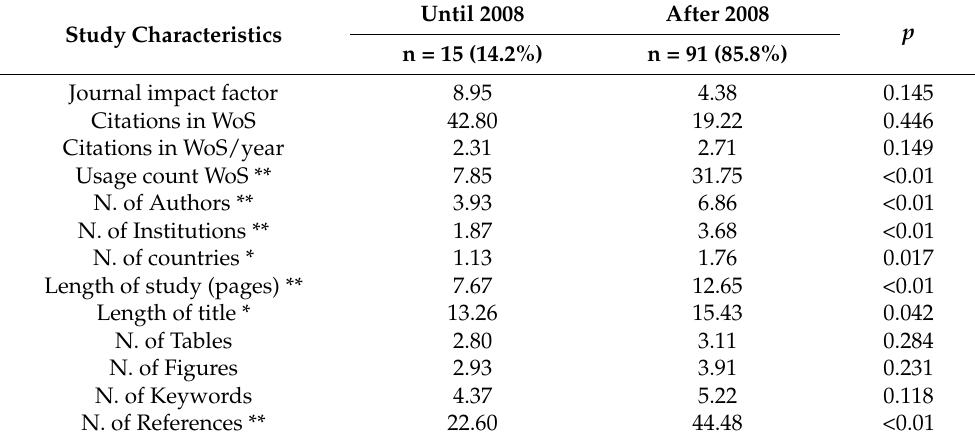
Table 4. Comparison of the averages of the studies published until 2008 and studies published after 2008 (journal impact factor, number of citations in WoS and usage count, the numbers of authors, institutions, and countries, study length and title, and numbers of tables, figures, keywords, and references). Until 2008 After 2008 p n = 15 (14.2%)